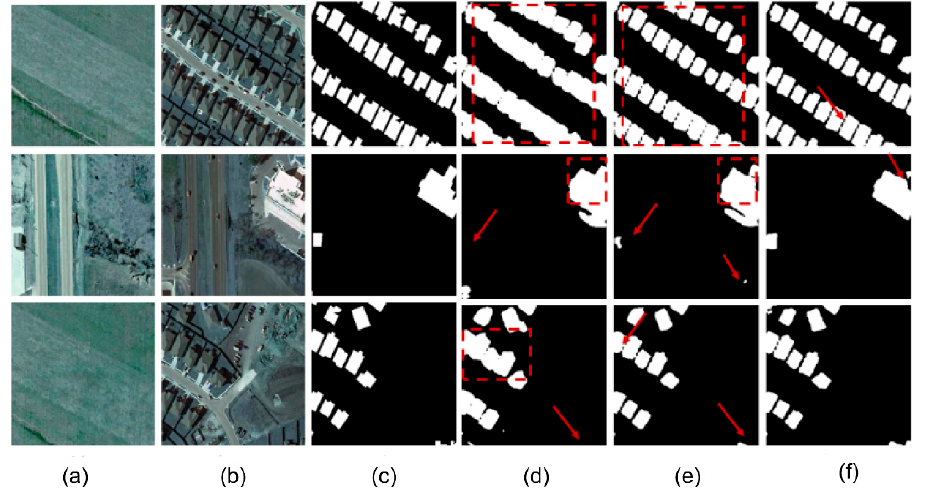
Figure 6. Comparison example of model experiment results on the LEVIR-CD dataset. From left to right: ( a ) Image T1, ( b ) Image T2, ( c ) truth map of change detection, ( d ) the result of FC-Siam-diff,